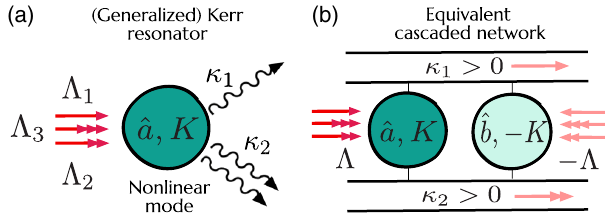
FIG. 1. (a) Generalized driven-Kerr-cavity problem, where a single interacting bosonic mode is subject to linear and nonlinear coherent drives Λ , as well as independent one- and two-photon j loss (rates κ 1 , κ 2 ). (b) The coherent quantum-absorber method represents each dissipative bath as a chiral waveguide and couples a second auxiliary b cavity downstream. By picking its Hamiltonian judiciously, the entire composite system can relax to a pure state, providing an efficient means for finding the steady state of cavity a